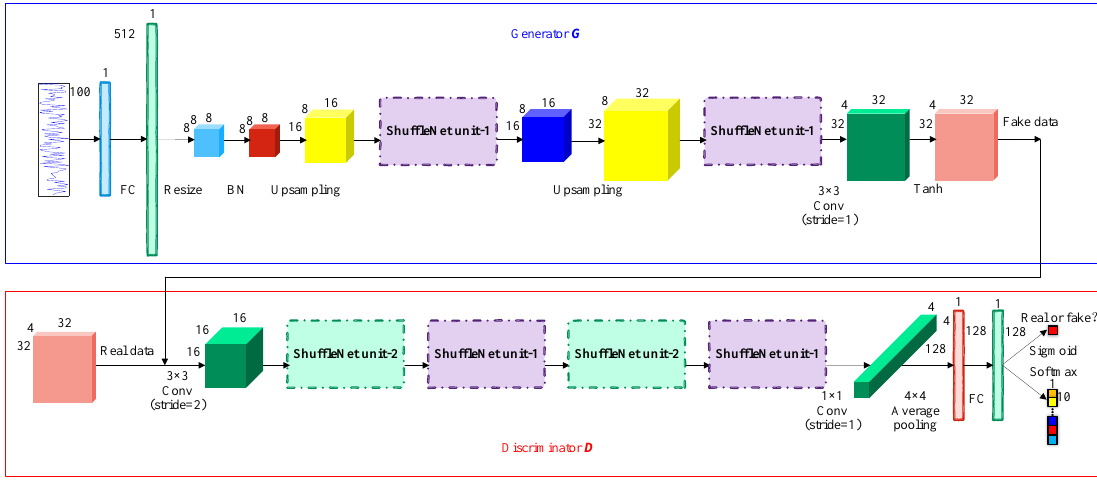
Figure 3. Architecture of the proposed